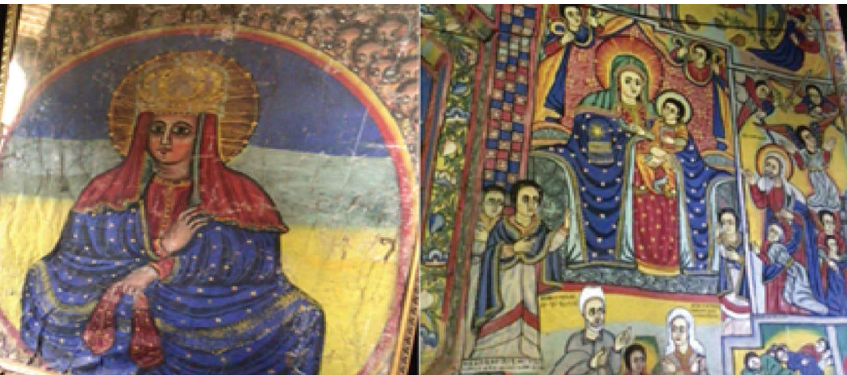
Figure 4: Saint Mary spiritual pictures at Saint George Church, Zegie, Bahir Dar, Ethiopia, painted 700years